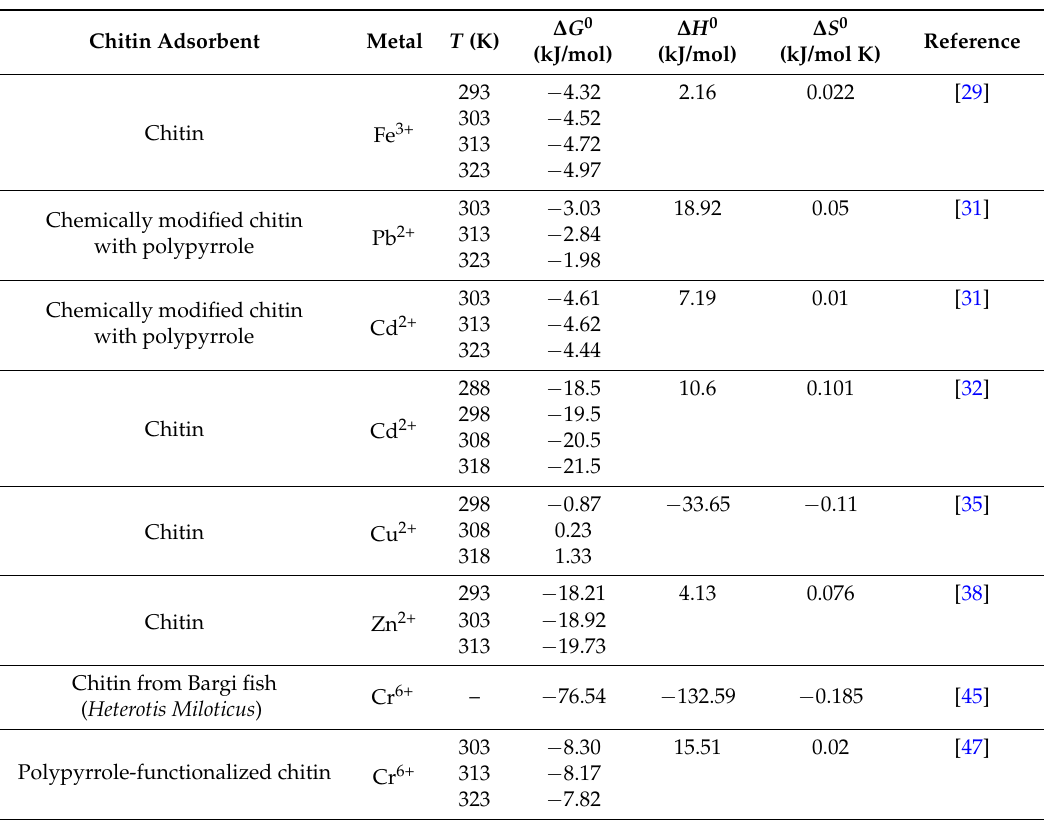
Thermodynamic parameters estimated for the adsorption of different metals onto chitin-based adsorbents. Chitin